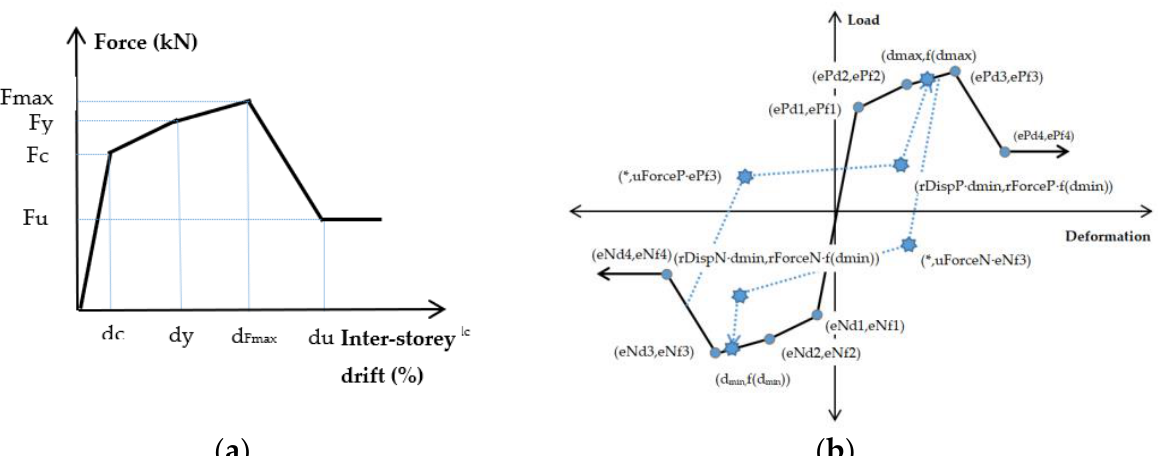
Figure 5. The nonlinear behavior of the central element: ( a ) the force – displacement relationship; ( b ) the Pinching 04 model.